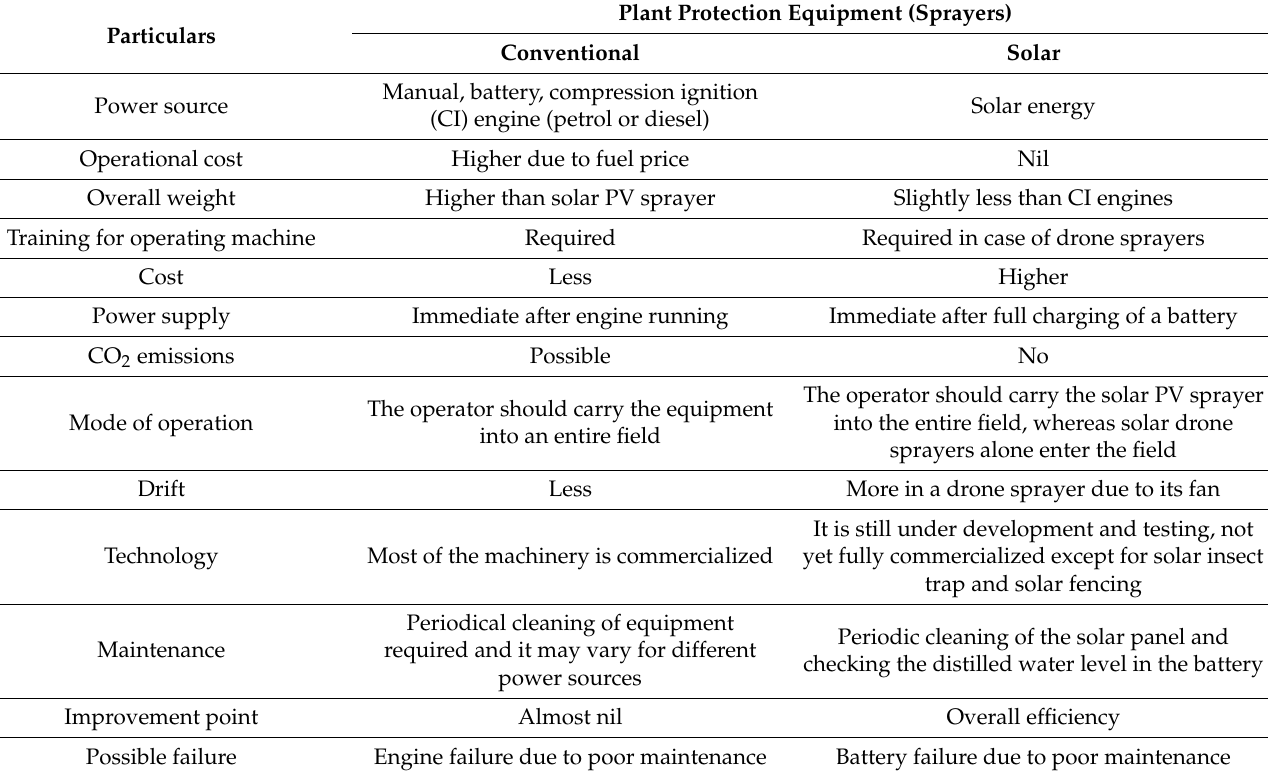
Table 5. Comparison of conventional and solar plant protection